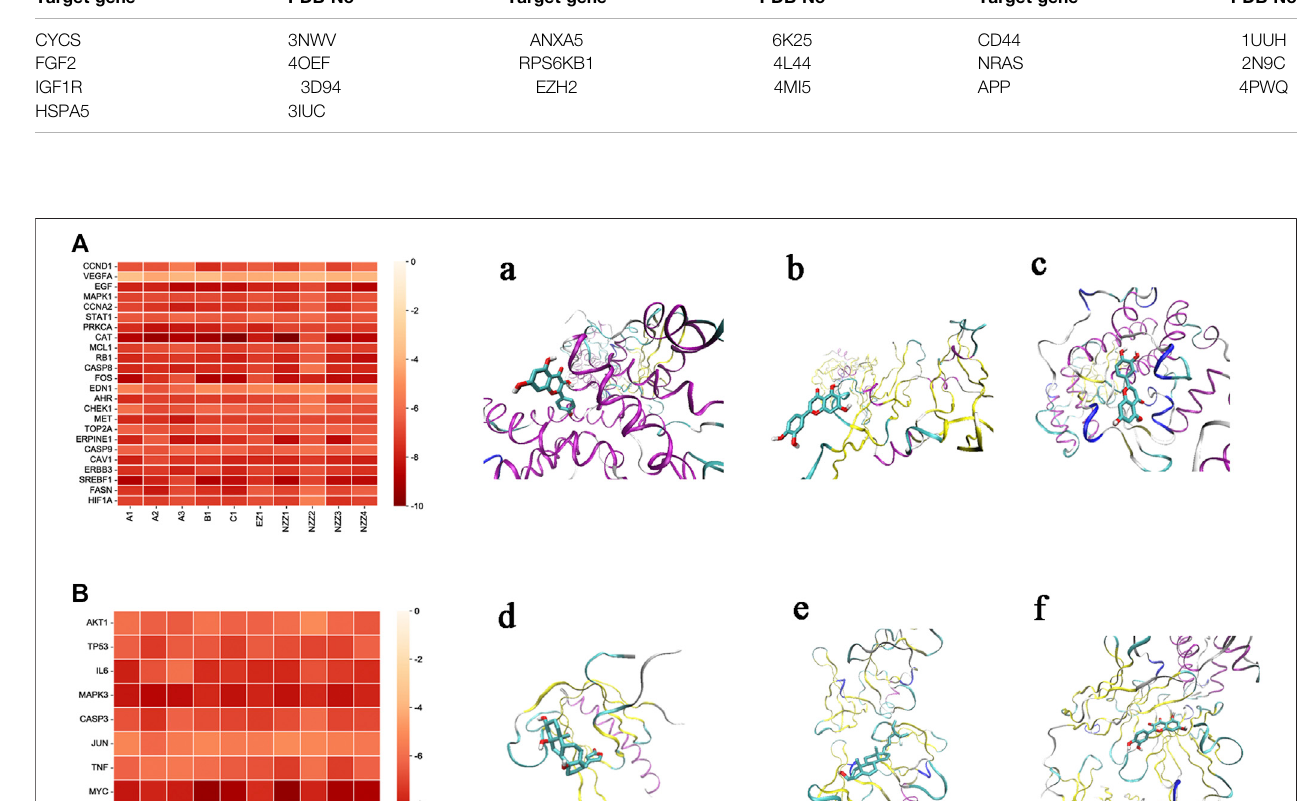
Frontiers in Pharmacology |